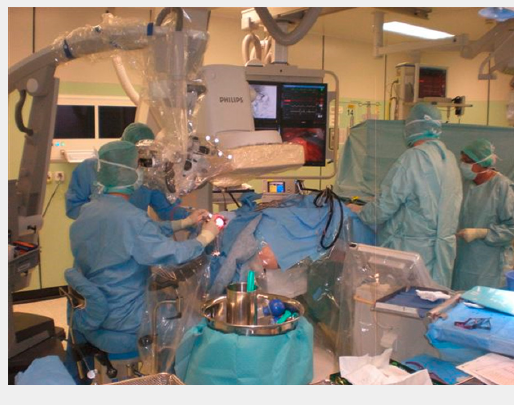
Treatment of an intracranial aneurysm in the hybrid operating room. Combined endovascular and microsurgical techniques for the treatment of intracranial aneurysm in the hybrid operating room (Neurocentre, Kantonsspital Aarau,